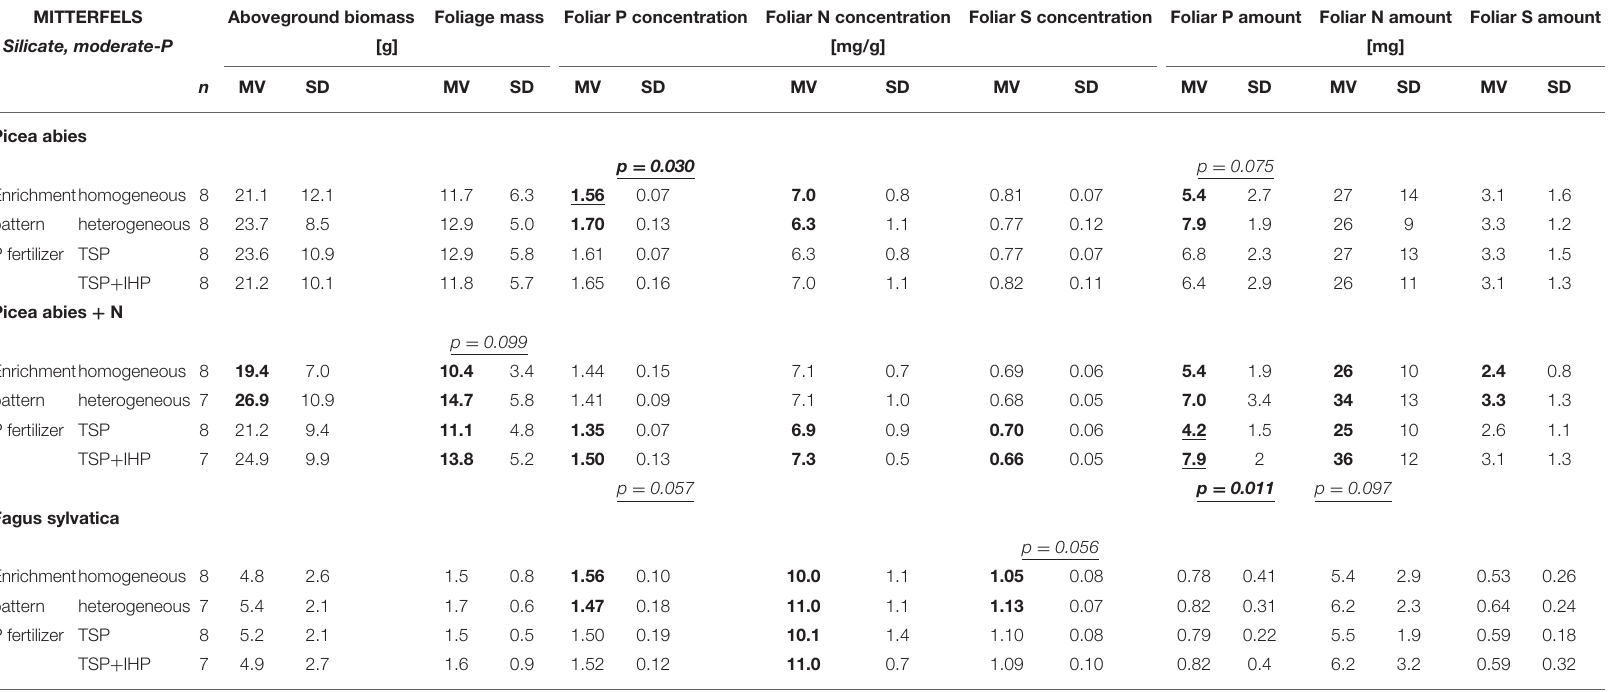
TABLE 3 | Effects of spatial P enrichment pattern and P fertilizer type on growth and nutrition of Picea abies and Fagus sylvatica seedlings in the field experiment at the moderate-P silicate site Mitterfels (Dystric